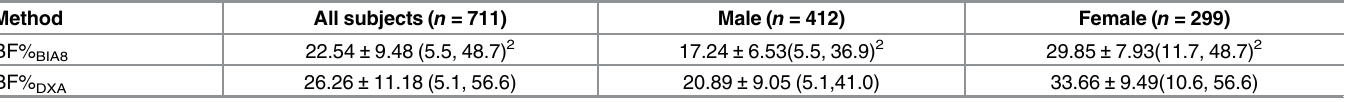
Table 2. Percentage body fat measured by standing-posture bioelectrical impedance analysis (BIA) and by dual-energy X-ray absorptiometry (DXA) 1 .